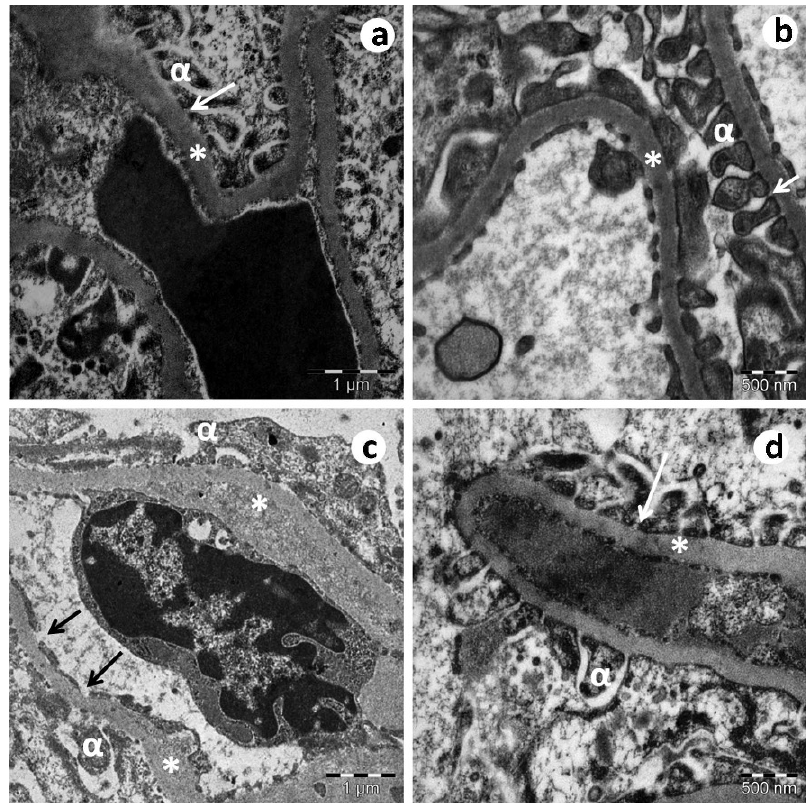
Figure 5 - An electron micrograph of a glomerulus. In the SED-SHR (c), the basal membrane (*) of the glomeruli exhibits a thickened appearance compared to the EX-SHR (d) and the control groups SED-WKY (a) and EX-WKY (b). In the glomerular filtration barrier, the slit diaphragm (arrow) and the pedicels ( a ) were more preserved in the SED-WKY (a), EX-WKY (b) and EX-SHR (d) compared to the SED- SHR (c). Abbreviations: EX, exercised; SHR, spontaneously hypertensive rats; SED, sedentary; WKY, Wistar-Kyoto rats.